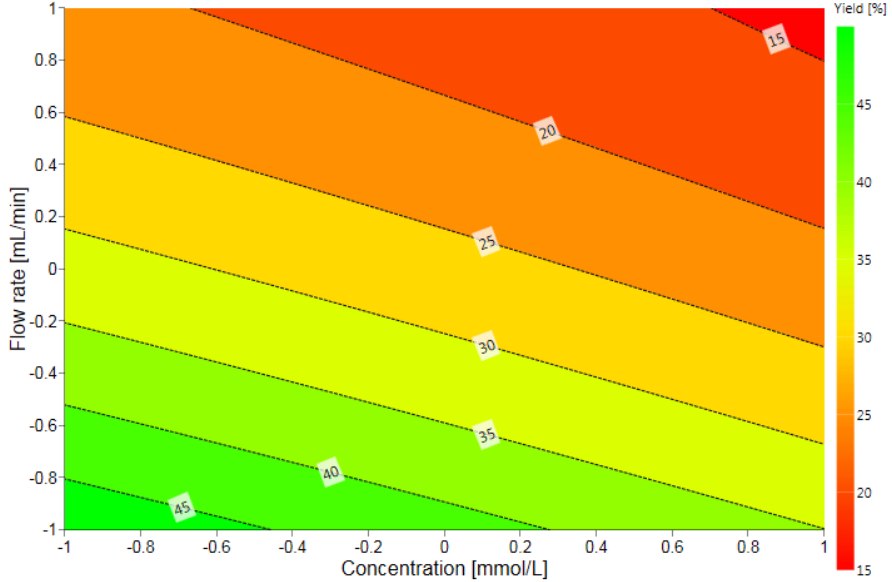
Figure 12. Contour plot for the performance of the continuous flow process for Ca 2 + cross-linked alginate. Stock: 250–750 mM of 2; 500–1500 mM (2 mol-eq.) of 1 in 0.1 M of TEOA bu ff er, pH 7.5, with 1.4% of DMSO. T = 32.5 ◦ C; flow rate: 0.1–0.5 mL / min; 350 mg of freeze-dried E. coli hosting DERA on 850 mg of lu ff a sponge (10 mL of 2% ( w / v ) Na-alginate solution); cross-linking by 2% ( w / v ) CaCl 2